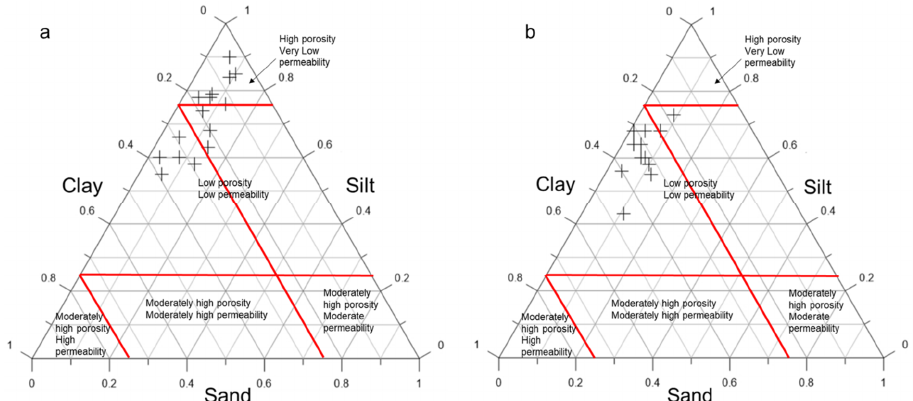
Figure 7. Ternary diagram of studied Cretaceous ( a ) and Paleogene/Neogene ( b ) kaolins based on their sand, silt, clay fraction percentages (Fields after [28]).